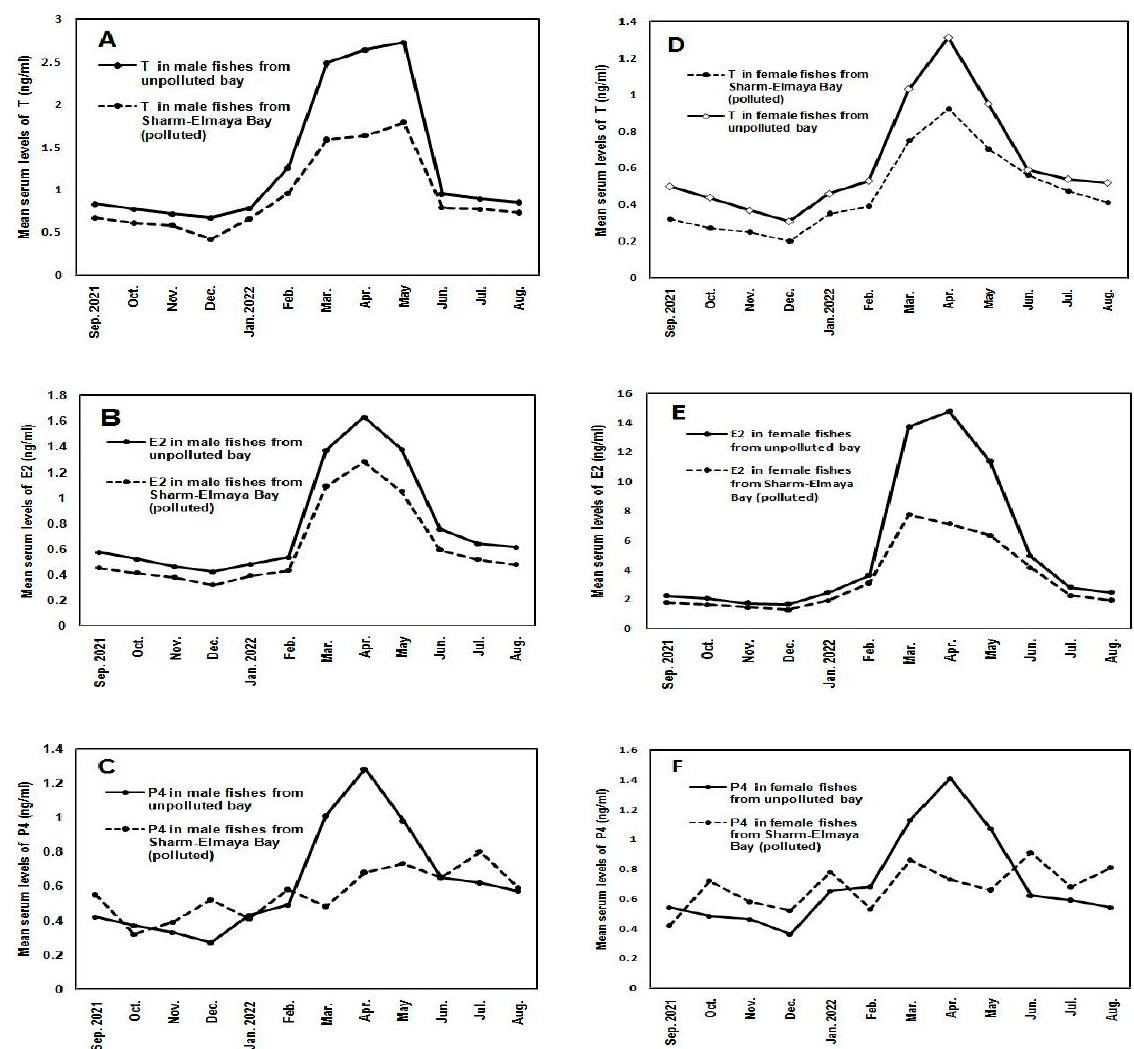
Figure 3. (A – F) : Monthly levels of serum sex steroid hormones in both sexes of S. rivulatus living in each bay.